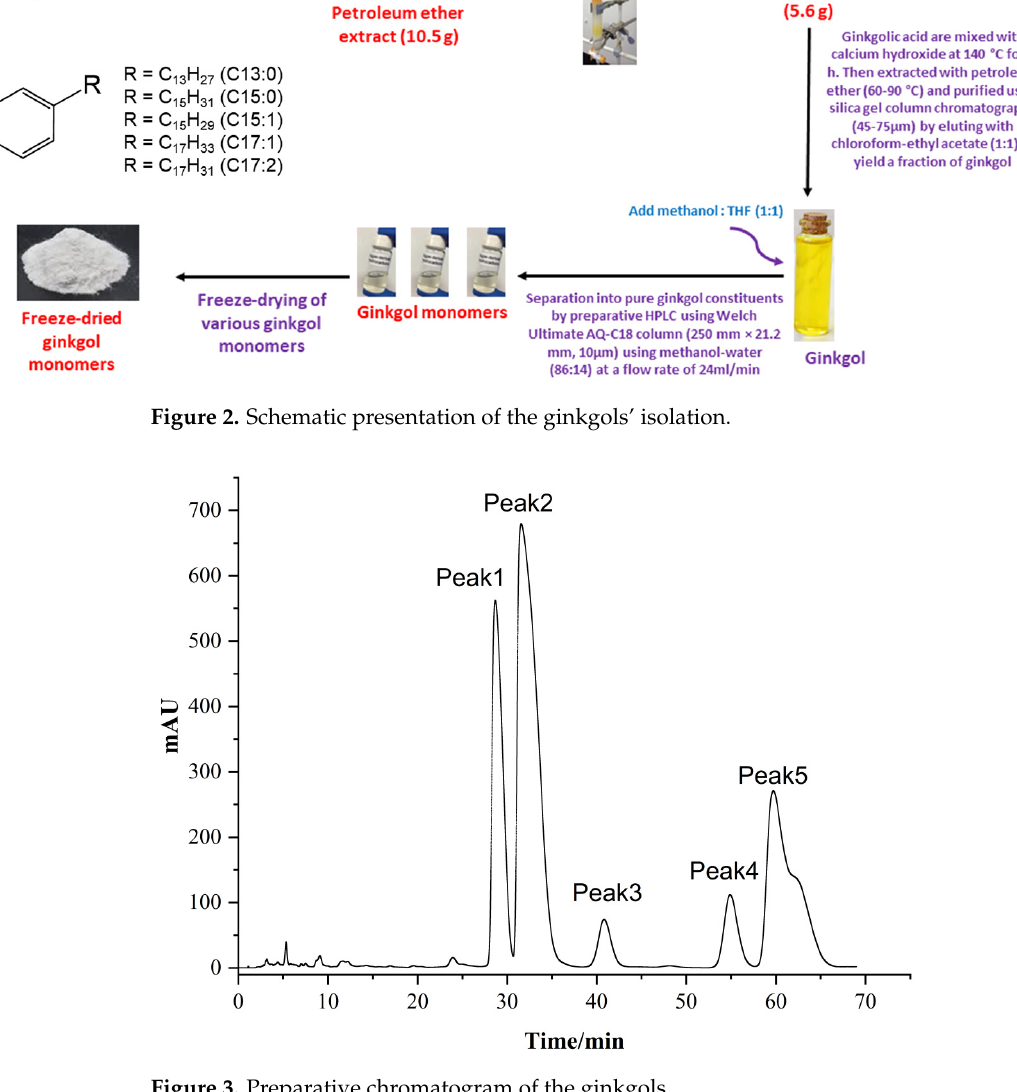
Figure 3. Preparative chromatogram of the ginkgols.